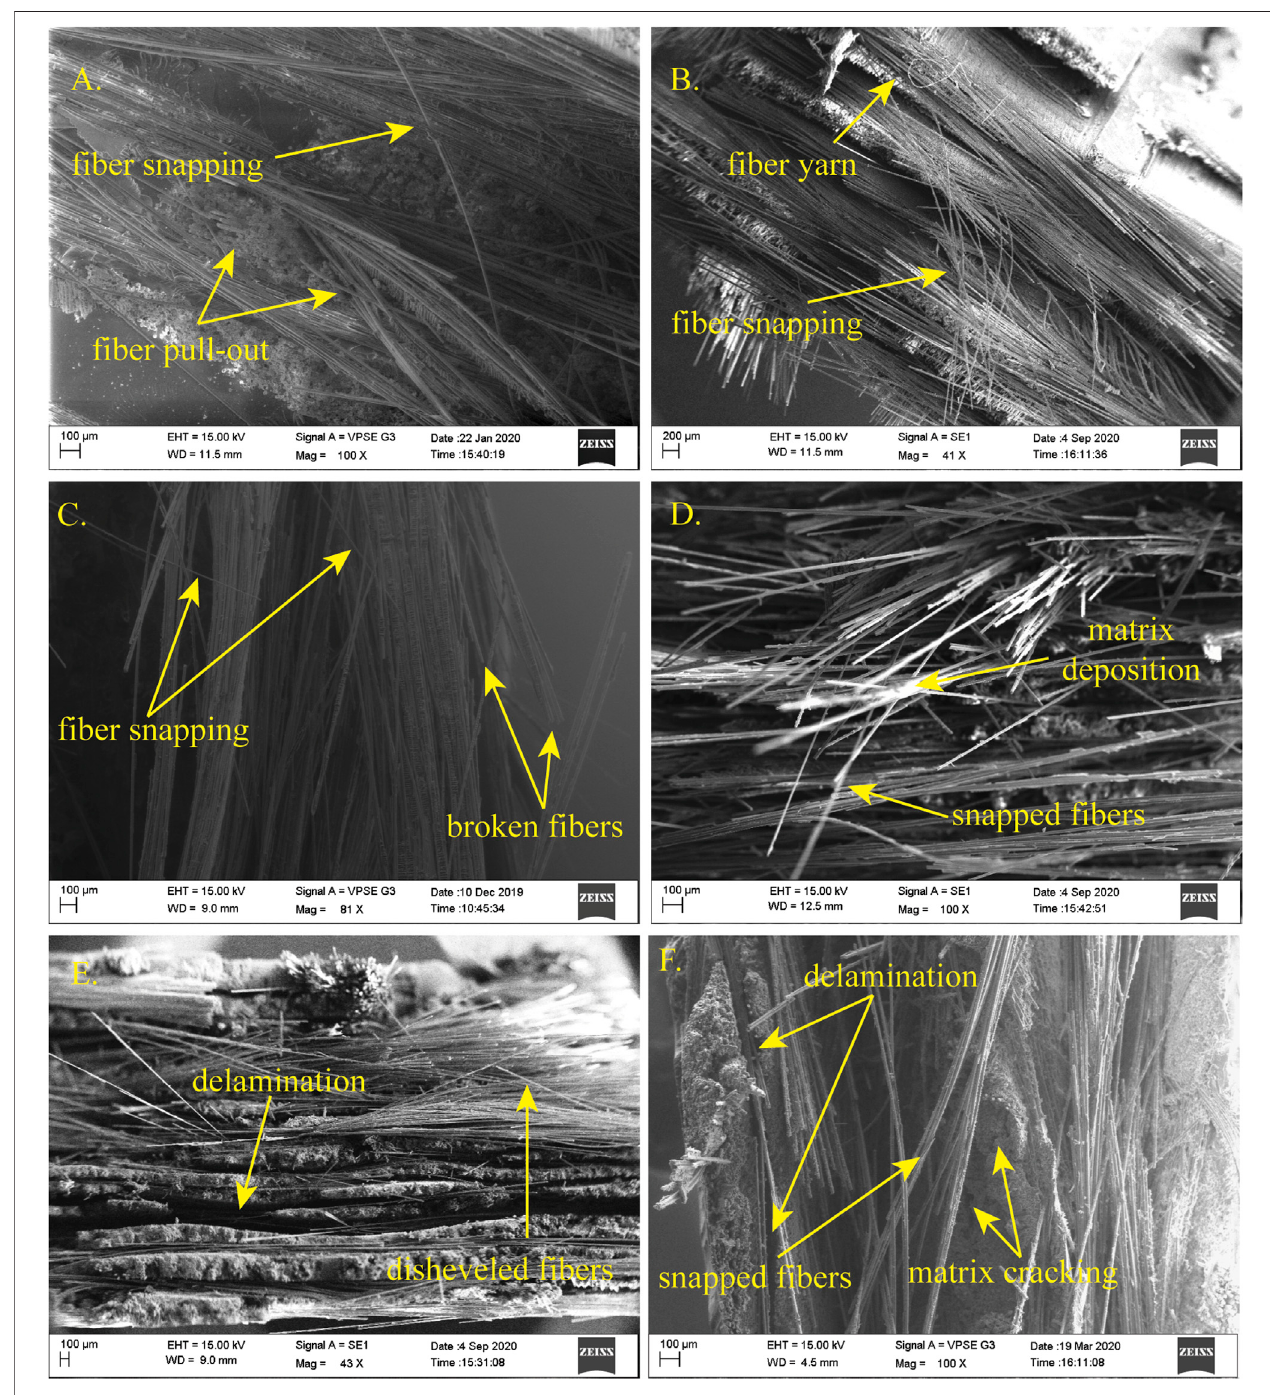
FIGURE 7 | SEM micrographs for impact specimens. (A) EGC, (B) MEG, (C) EBC, (D) MEB, (E) HGB, (F) MHC.